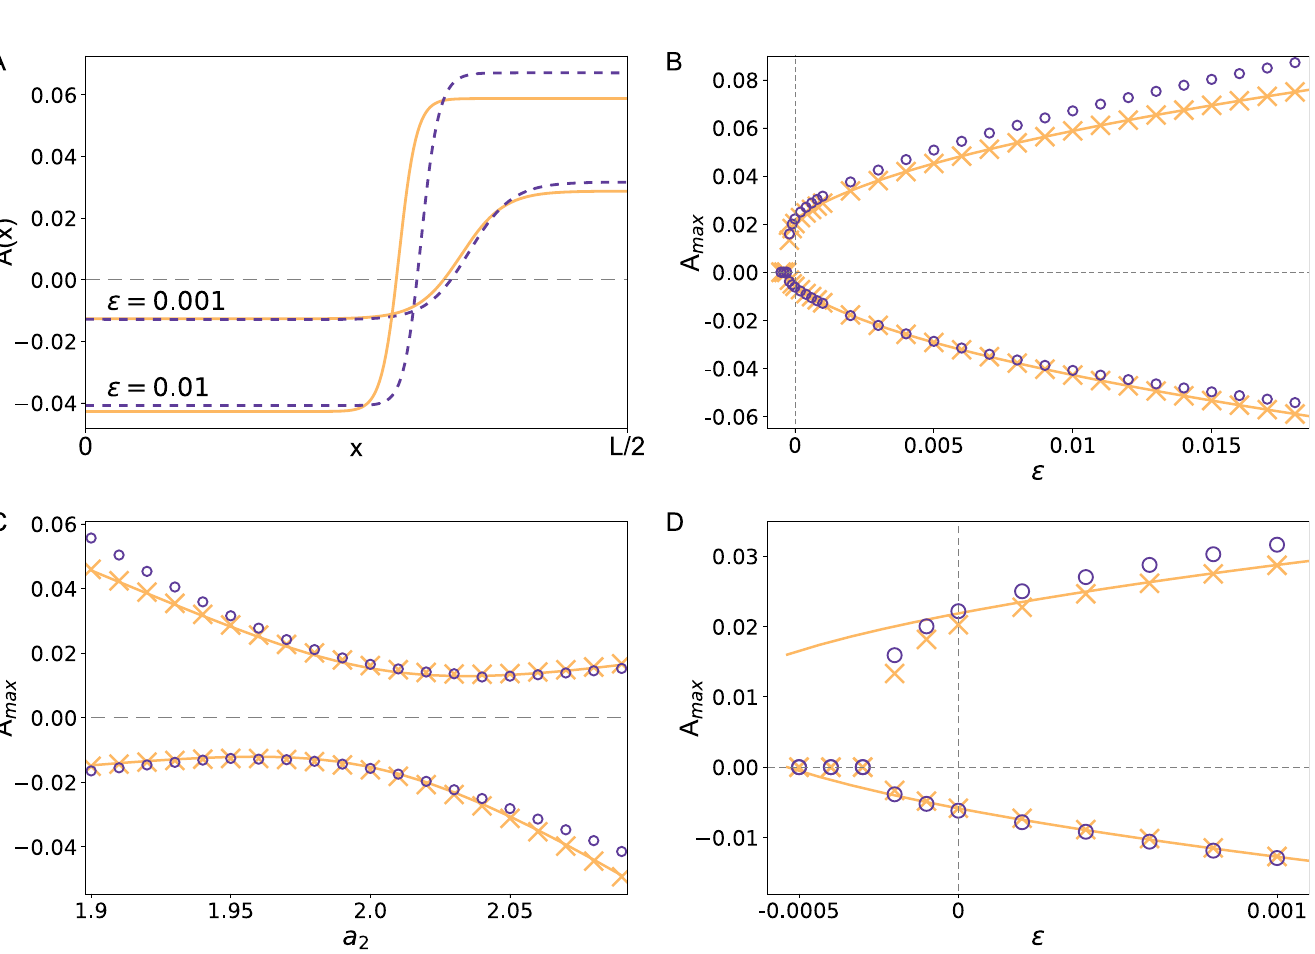
(cid:0) ~ v ð x ÞÞ = f (dashed lines) and the solution A h u